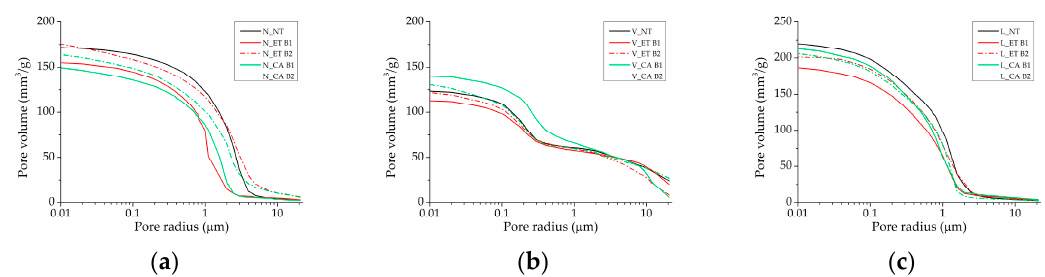
Figure 8. Pore volume (mm 3 /g) versus pore radius reported as a comparison between untreated and treated samples: ( a ) Noto stone; ( b ) Vicenza stone; ( c ) Lecce stone.